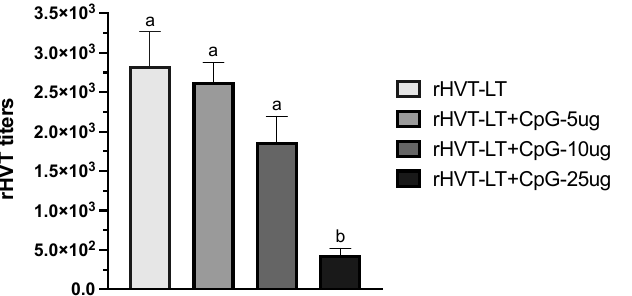
Figure 1. Effect of CpG-ODN on rHVT-LT vaccine-virus replication in vitro. Monolayer cultures of chicken embryo fibroblasts (CEFs) were infected with one dose of vaccine and with three serial 10-fold dilutions. Vaccine ± CpG-ODN doses (5, 10, and 25 µ g) were titrated in triplicate and the growth of the virus was determined through assessing the cytopathic effect on CEFs using an inverted microscope. Titration was evaluated through counting the number of plaque-forming units (PFUs). Different letters above the standard-error-of-mean bars indicate significant difference ( p < 0.05) between the groups. Table 2. Chick hatchability following in ovo administration of vaccine ±